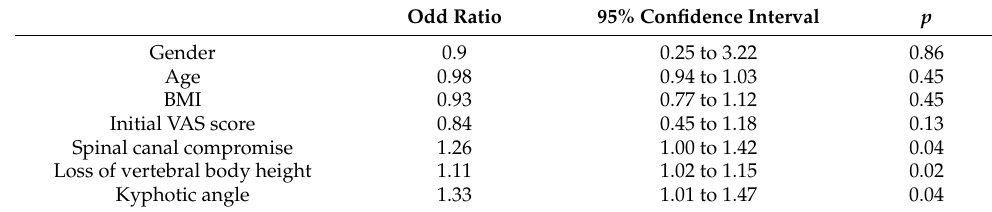
Table 5. Simple logistic regression analysis of nonoperative treatment failure.